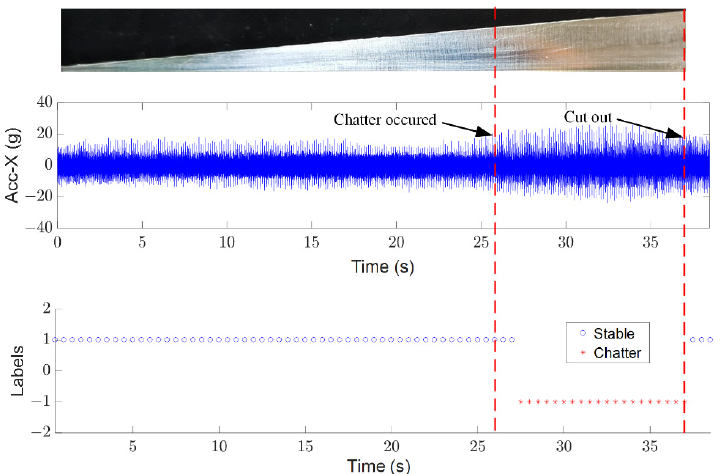
Figure 9. Chatter identification results with proposed method (spindle speed 4500 rpm, feed rate 400 mm/min, and radial cutting depth 2.5 mm).